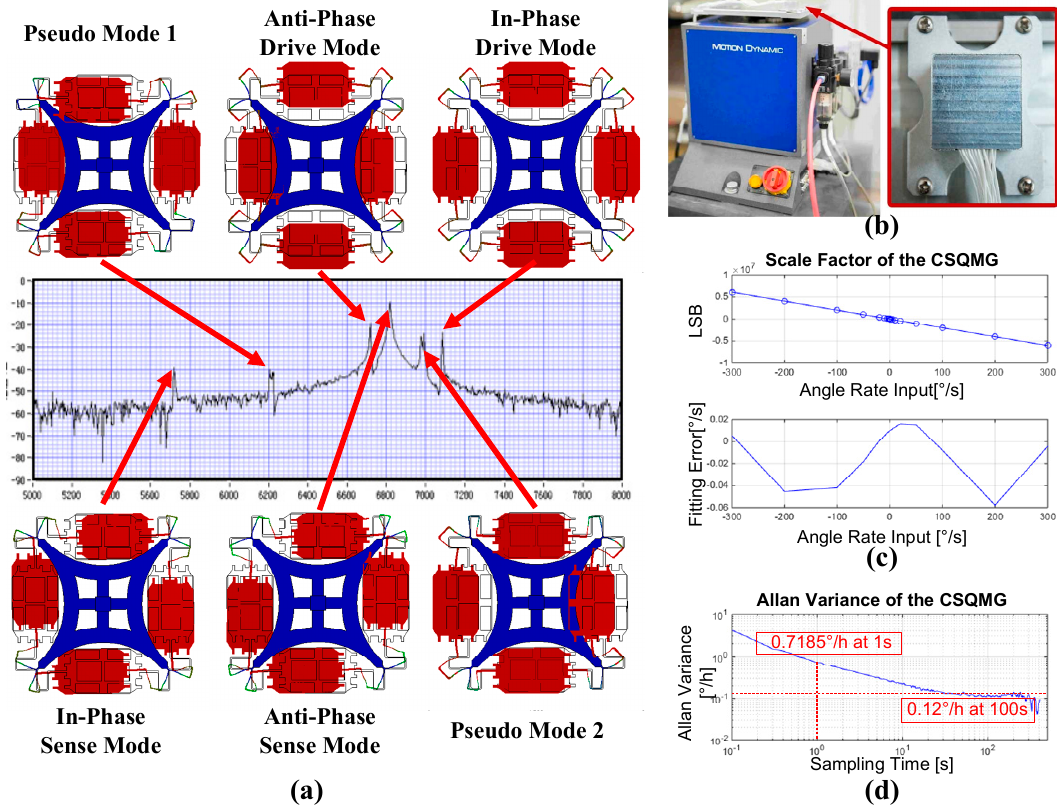
Figure 12. ( a ) Frequency response curve of the CSQMG. Sine excitations are applied on the drive combs and the signal read on sense combs, then all planar modes are reflected on the curve by vibration coupling; ( b ) Photograph of the Motion Dynamics 3V-AB 1-Axis Rate-Table (left) and fully packaged CSQMG (right); ( c ) Measured scale factor of the CSQMG. Above is the fitting result, below is the residual error. The scale factor is 20209.2LSB/(°/s) under ±300°/s measurement range, and nonlinearity is 96 ppm; ( d ) Measured Allan variance stability of the CSQMG. The white noise level is about 0.7185°/h/ √ Hz. The Allan variance stability is 0.12°/h (100 s) at room temperature.